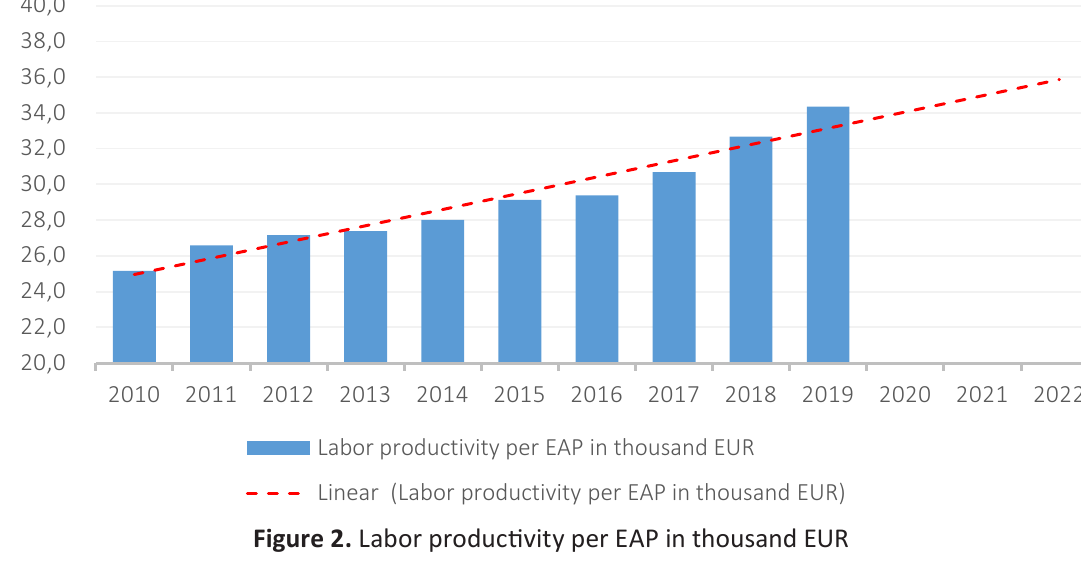
Figure 2. Labor productivity per EAP in thousand